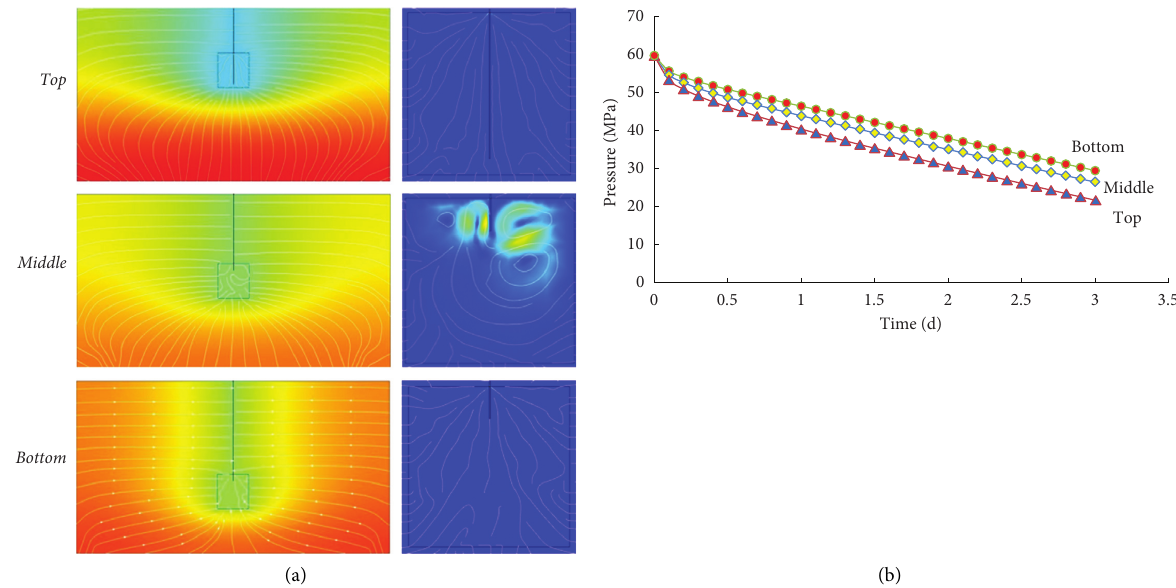
Figure 9: Distribution of pressure and velocity field at different fracture-cavity positions (a) and pressure comparison of different fracture- hole positions